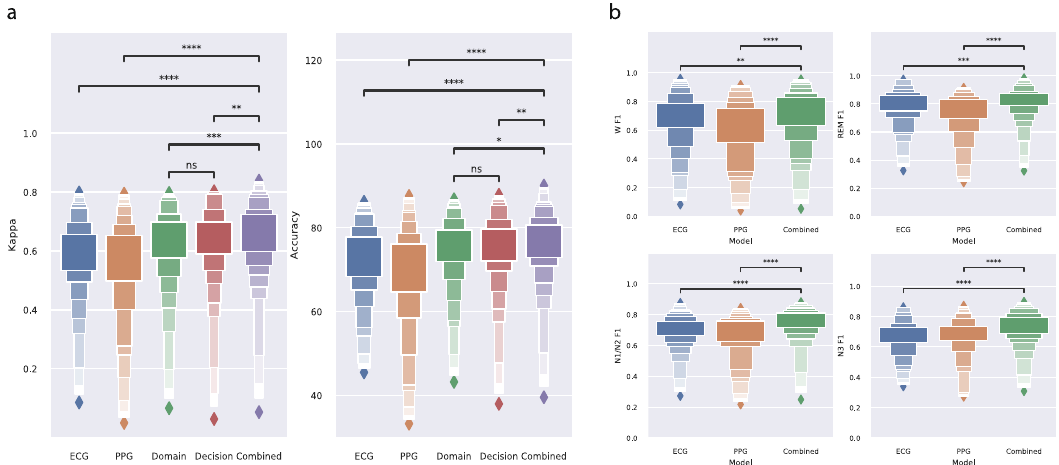
Fig. 5 Comparison of sleep stage classi fi cation performance. a Evaluation of different model training strategies on the Eindhoven PPG data set. Distributions of participants in the data set are shown using letter value plots, in which box sizes are proportional to the number of participants in the box range. Performance reported in Cohen ’ s kappa and accuracy. b Comparison of the combined retrain transfer learning strategy with the two non- transfer baselines for each sleep stage, presented in F1 score. The same letter value plots and statistical testing annotation are used. Statistical comparisons between different models have been performed using Wilcoxon ’ s signed rank test (two-sided). Stars denote p -value of the test, where *, **, ***, and **** denote p <0.05, p <0.01, p <0.001, and p <0.0001, and “ NS ” denotes “ not signi fi cant ” or p